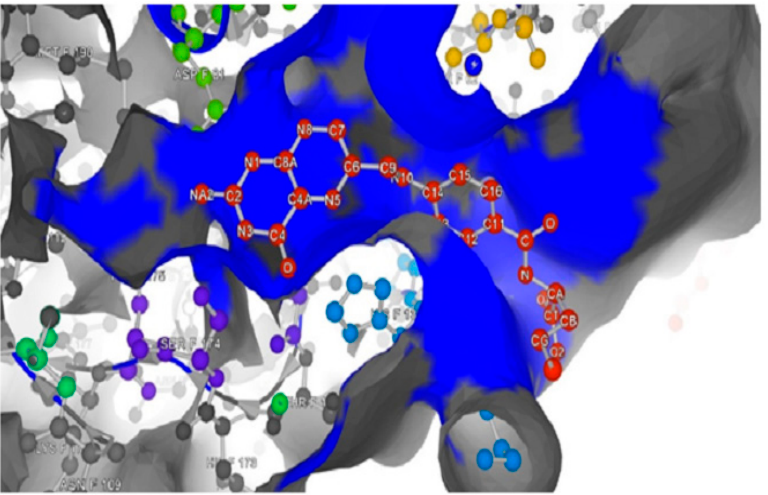
Figure 2. P2Rank prediction for folate receptor α (FR α ) complex with FA (PDB:4LRH), the prediction of the binding pocket is indicated by a blue color and the FA is shown with red balls and gray sticks.